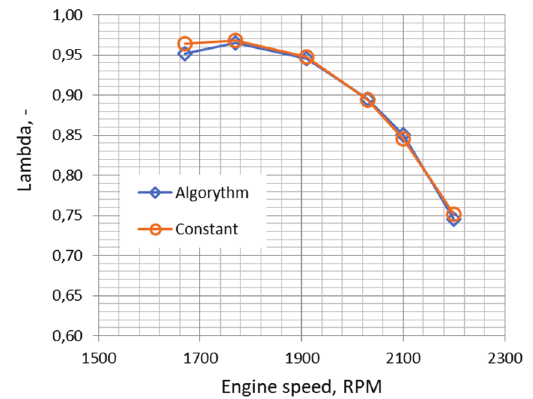
Fig. 17. Relationship between fuel ratio and rotational speed for constant and variable ignition advance